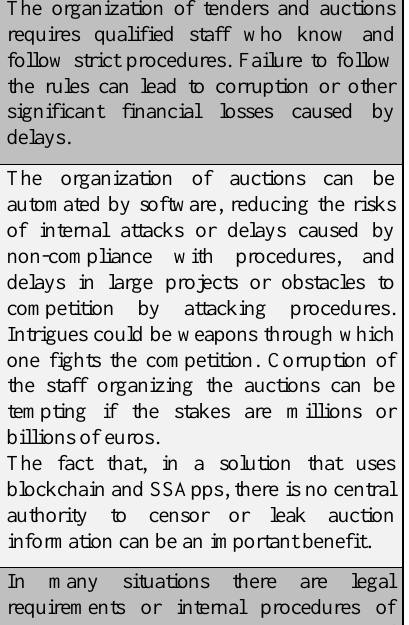
Table 1. Merits and use of the SSApps in the procurement